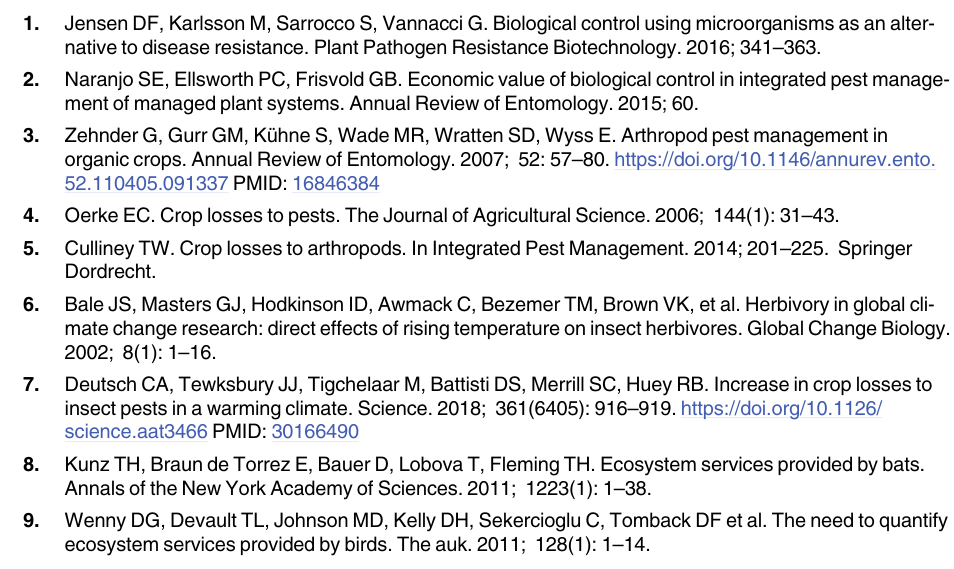
S2 Table. List of prey and non-prey species found in the faeces of R . hipposideros with each primer